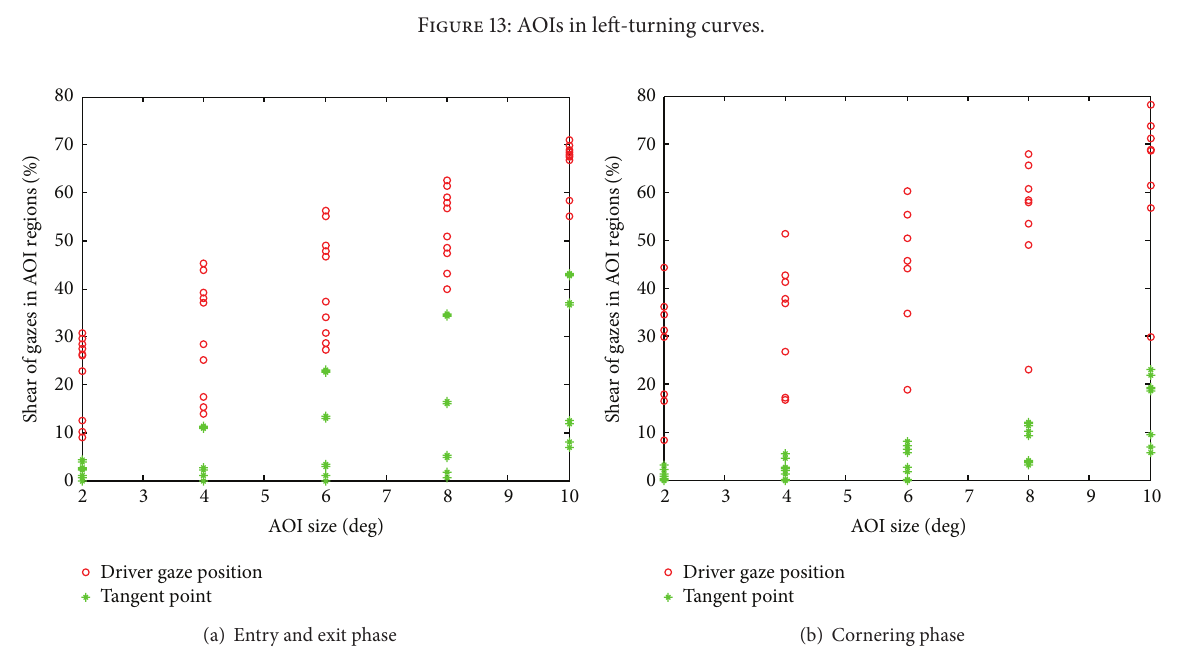
Figure 13: AOIs in left-turning curves.